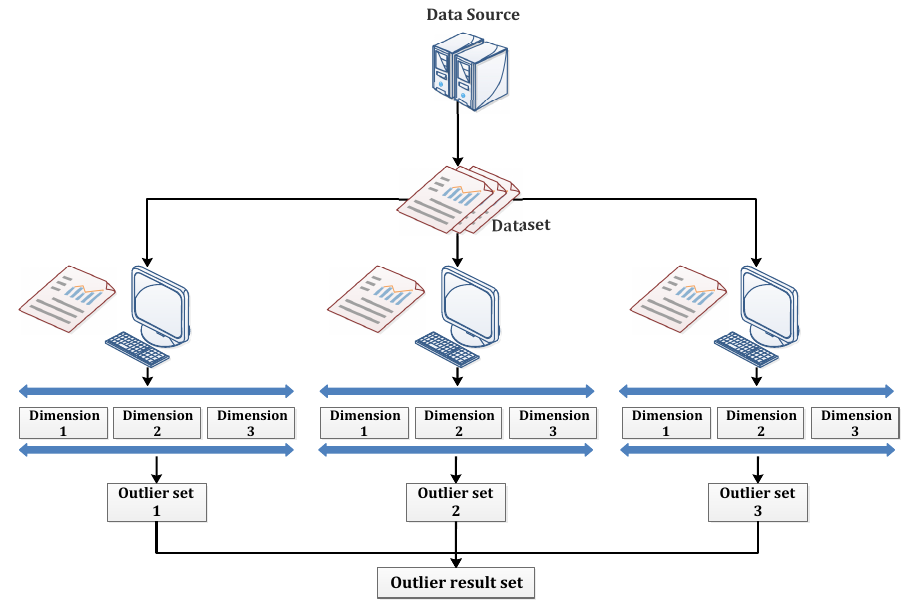
Figure 5. Multi-node outlier detection processing flow